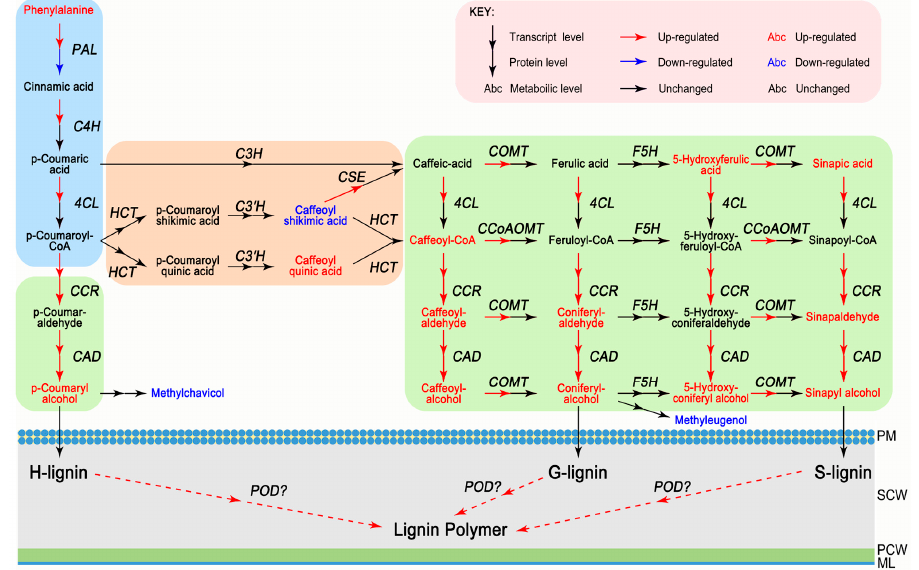
Figure 6. Integration of nano-CaCO 3 treatment-induced P. lactiflora inflorescence stems mRNAs, proteins, and metabolites in the phenylpropanoid biosynthesis pathway. PM, plasma membrane; SCW, secondary cell wall; PCW, primary cell wall; ML, middle lamella. PAL , phenylalanine ammonia-lyase gene; C4H , cinnamate 4-hydroxylase gene; C4L , 4-coumarate-CoA ligase gene; CCR , cinnamoyl-CoA